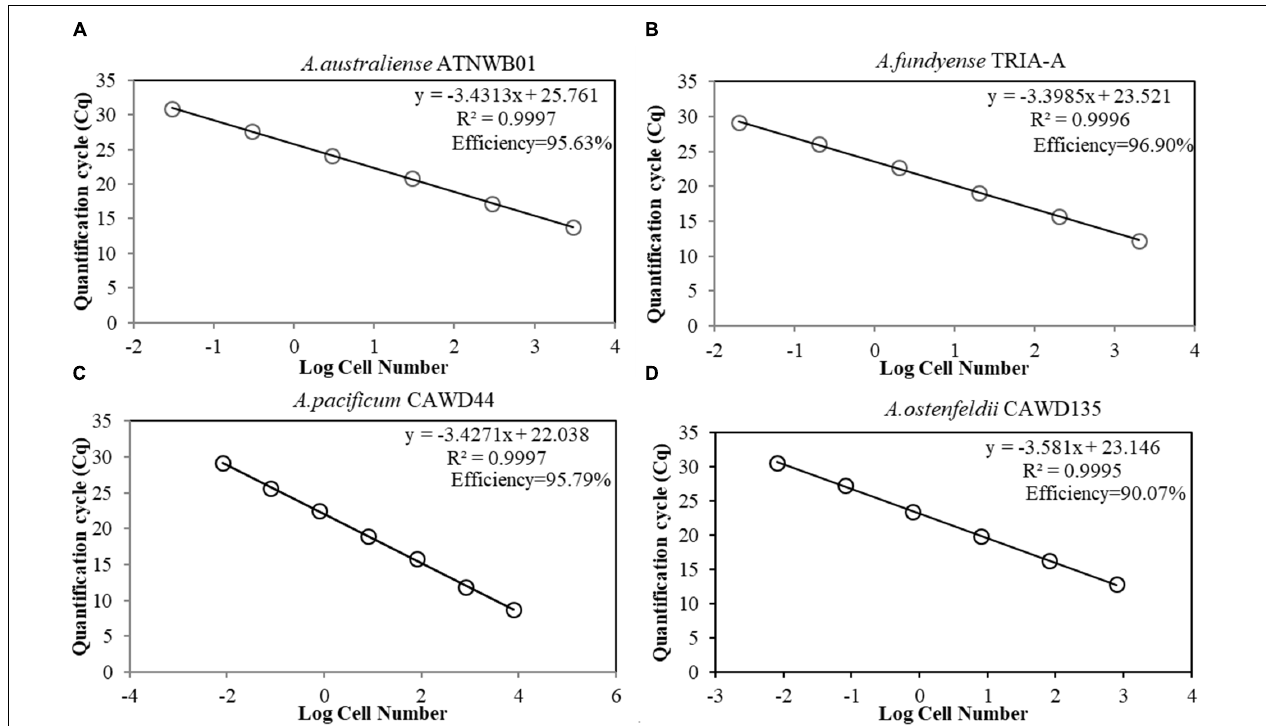
FIGURE 3 | (A–D) Standard curves of species-specific assays for Alexandrium spp., presenting the quantification cycle ( y -axis) versus the known cell number in log scale ( x -axis). (A) A. australiense strain ATNWB01 standard curve. (B) A. catenella strain TRIA-A standard curve. (C) A. pacificum strain CAWD44 standard curve. (D) A. ostenfeldii strain CAWD135 standard